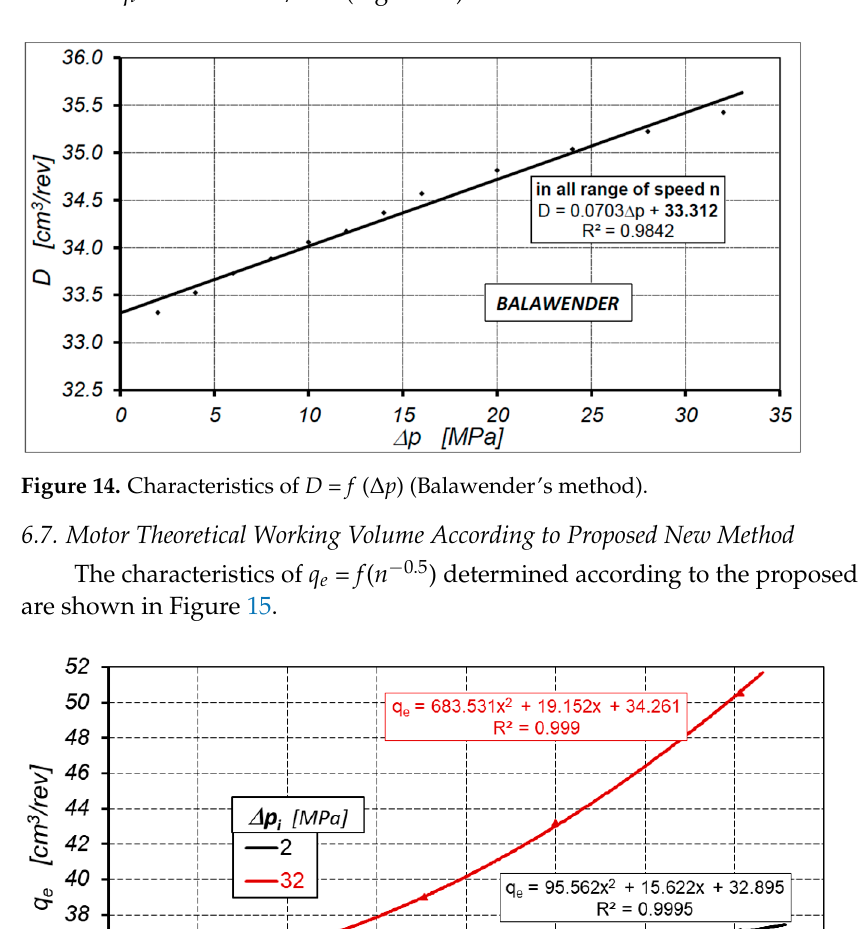
Figure 13. Characteristics of q e = f(n − 1 ) at Δ p=const .—according to Balawender’s method. According to the Balawender method, the theoretical working volume q t of the satellite motor is q t = 33.312 cm 3 /rev. (Figure 14).